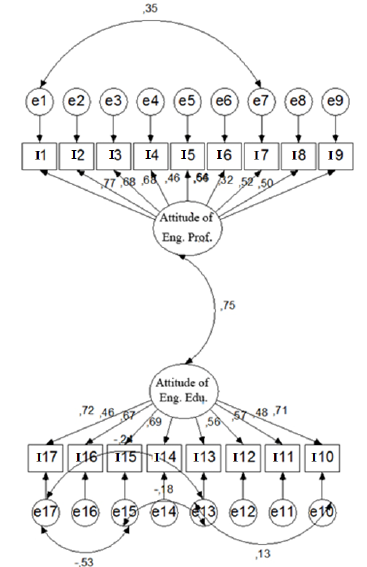
Fig. 2. Confirmatory Factor Analysis Correlation Diagram